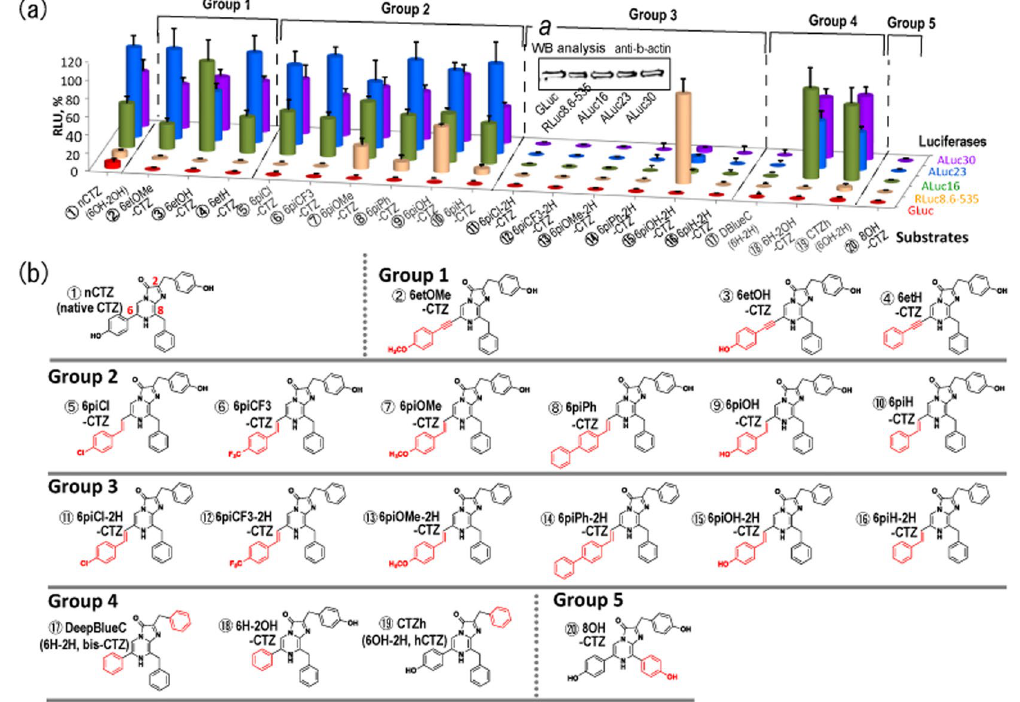
Figure 1. ( a ) Relative optical intensities of marine luciferases to the synthetic luciferins. The optical intensities of five marine luciferases to each luciferin were normalized to the maximal intensity. The synthetic luciferins were grouped into five categories according to their chemical structures. Inset a shows a Western blot analysis indicating relative protein amounts between the marine luciferases. The house-keeping protein, β -actin, was stained with a specific antibody. (b ) The detailed chemical structures of synthetic coelenterazine analogues. Compound ① (native CTZ; nCTZ) and its derivatives are categorized into five groups: Group 1 contains an ethynyl group at the C-6 position. The distinctive feature between groups 2 and 3 is the presence or absence of the hydroxyl (OH) group at the C-2 phenyl ring. Both groups 2 and 3 share extension of the double bond conjugated system at the C-6 position. Group 4 analogues lack the OH group at the C-2 and/or C-6 positions, upon comparison with nCTZ. Group 5 has an OH group at the C8 position. The characteristic functional groups in the chemical structures are highlighted in